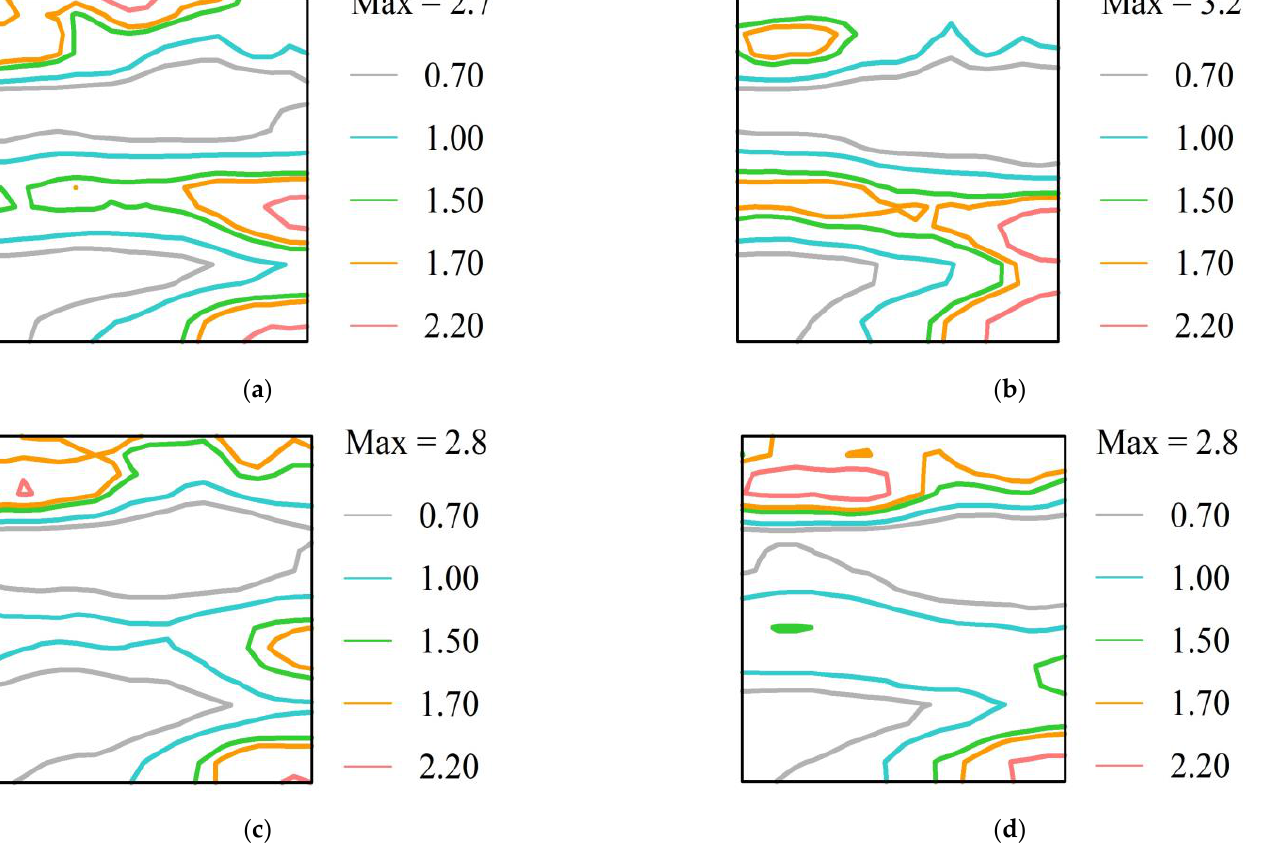
Figure 8. φ 2 = 45°section of ODF representing the texture for different target P content samples: ( a ) 0.06%P, ( b ) 0.10%P, ( c ) 0.14%P, and ( d ) 0.18%P.